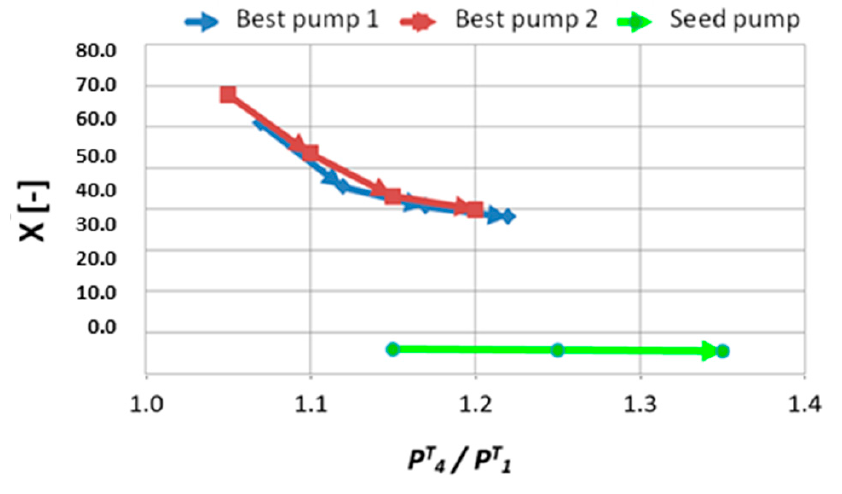
(cid:2176) /(cid:2172) (cid:2781)